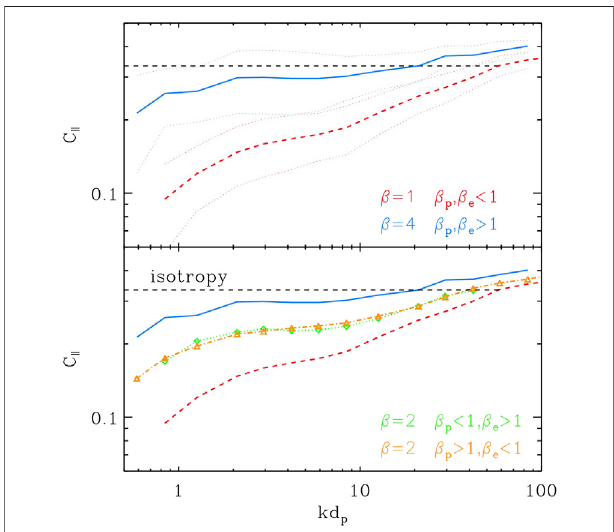
FIGURE 8 | Cluster average spectra of magnetic compressibility for intervals with β e and β p < 1 (red) and β e and β p > 1 (blue); in the bottom panel, intermediate values with similar average β but with β p < 1, β e > 1, and β p > 1, β < 1 are also shown in green and orange, respectively. Thin dotted e lines in the upper panel show the one-sigma dispersion of the